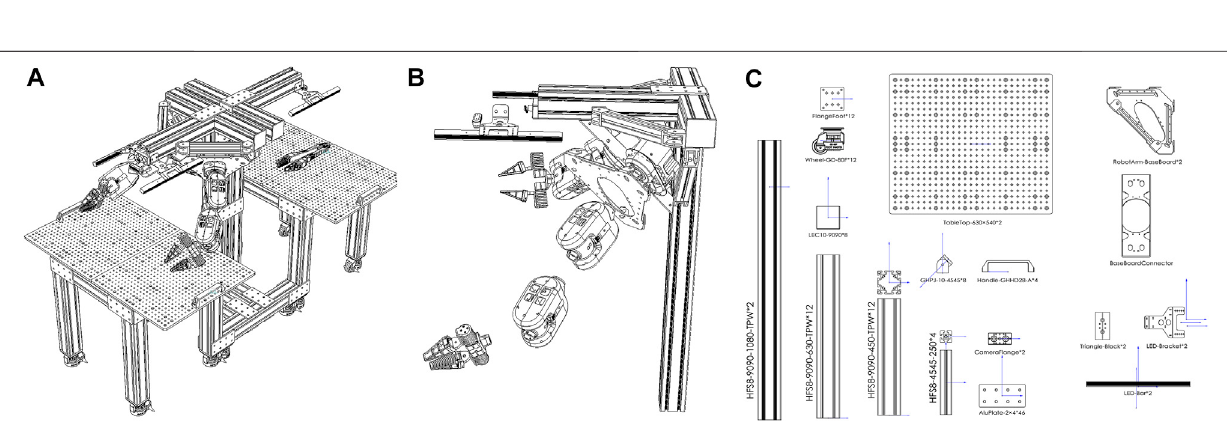
Frontiers in Robotics and AI |